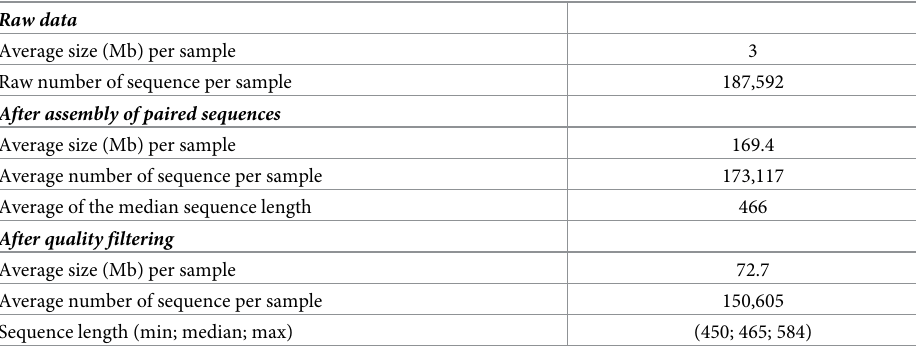
Table 1. Summary of sequencing